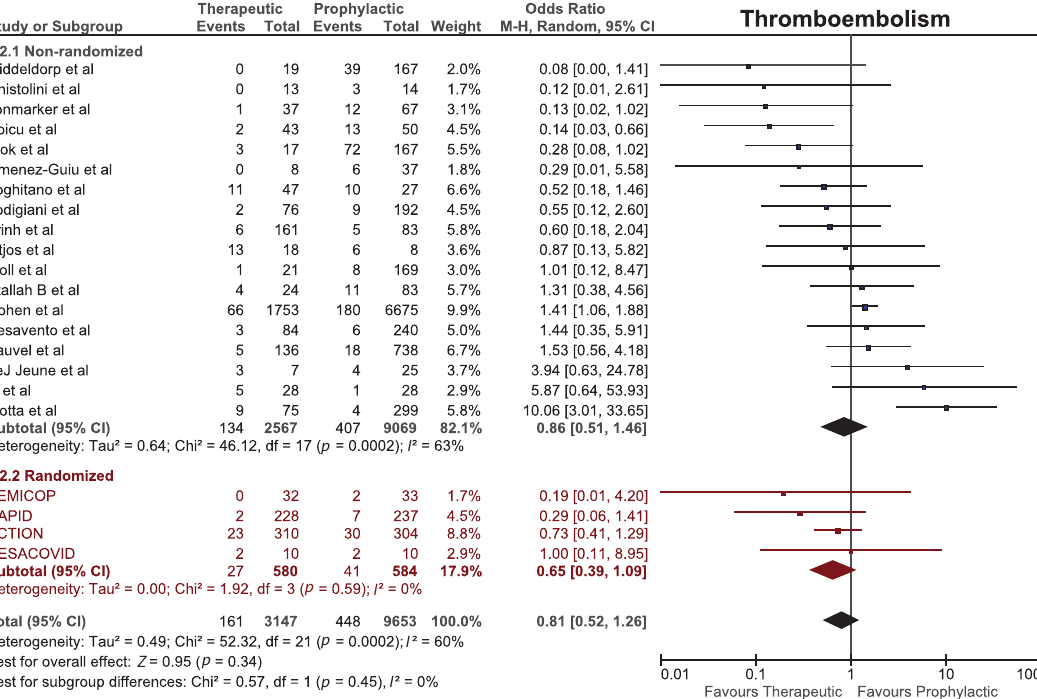
Fig. 3 Forest plot for thromboembolism with therapeutic versus prophylactic doses of anticoagulation. CI, con fi dence interval.